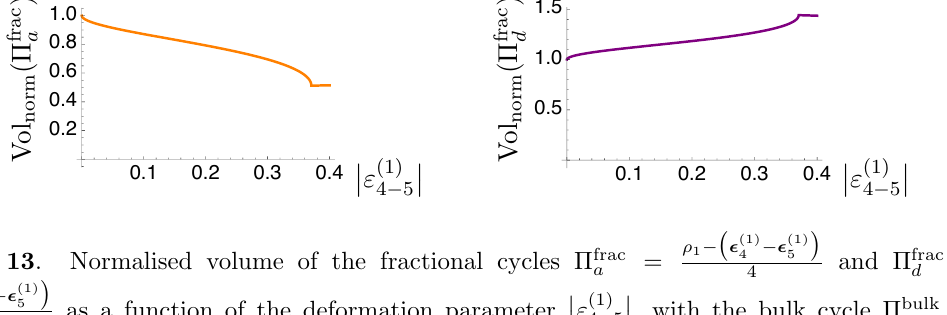
Figure 13 . Normalised volume of the fractional cycles (cid:5) frac (cid:0) (cid:1) (cid:26) 1 + (cid:15) (1) 4 (cid:0) (cid:15) (1) 5 as a function of the deformation parameter 4 ing along the cycle C 0 (cid:2)C 0 on T 4 describing the fractional three-cycle volumes as a function of some deformation along the (cid:13)at direc- tion in the twisted complex structure modulus (cid:16) (1) the plots will represent the normalised volume of a fractional three-cycle (cid:5) x + (cid:5) x 0 =